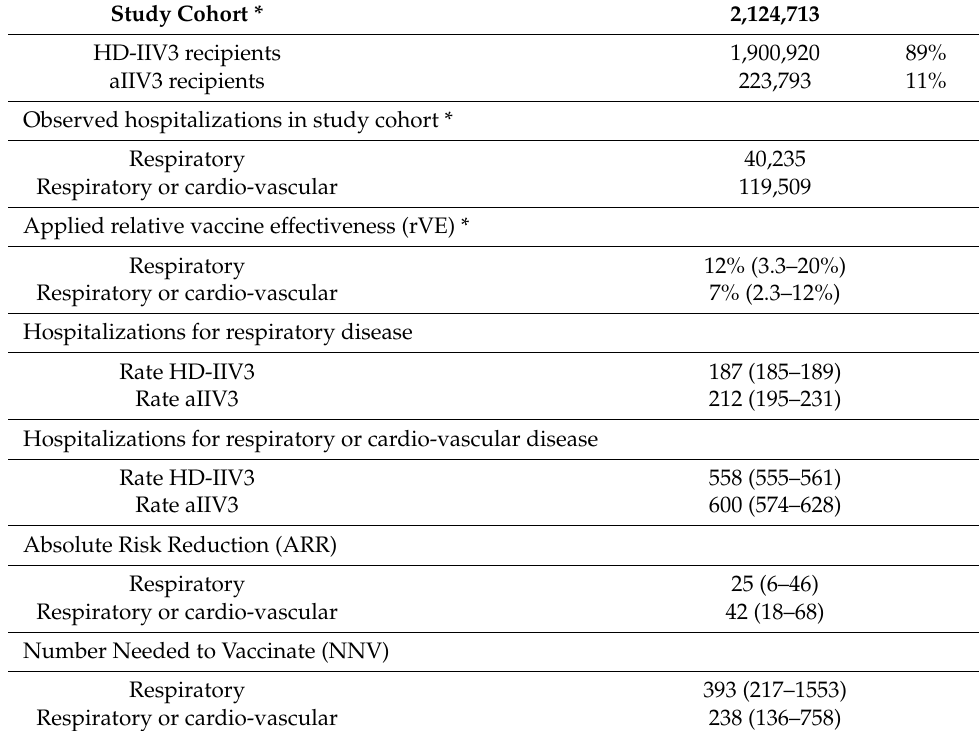
Table 1. Number of influenza vaccinations, hospitalization rates for respiratory or cardio-vascular disease, and number needed to vaccinate (NVV) to prevent one hospitalization for members of members of large national managed health care company in the U.S. during respiratory seasons 2016/17 through 2017/18. All rates are per 10,000